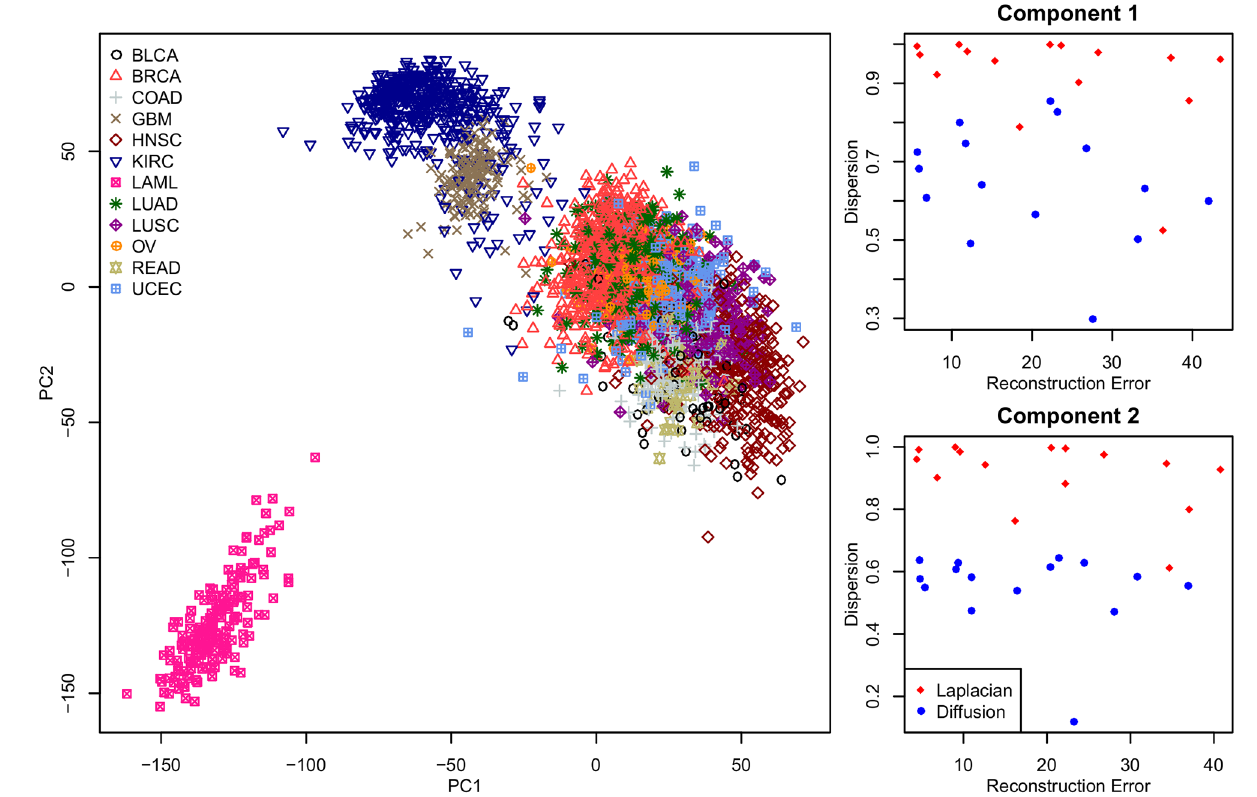
Fig 7. Comparison of GELnet models constructed using the Laplacian and the Diffusion kernel in an unsupervised setting. The left panel shows the first two principal components of the PanCan12 dataset with samples colored by tissue-of-origin. The right two panels present the performance of GELnet models constructed using the Laplacian (red) and the Diffusion kernel (blue) of Pathway Commons. The x-axis captures how well each model reconstructs the unregularized principal component, measured via RMSE. The y-axis captures the dispersion. Individual points correspond to the 15 settings of the λ 1 and λ 2 sampled over a grid of